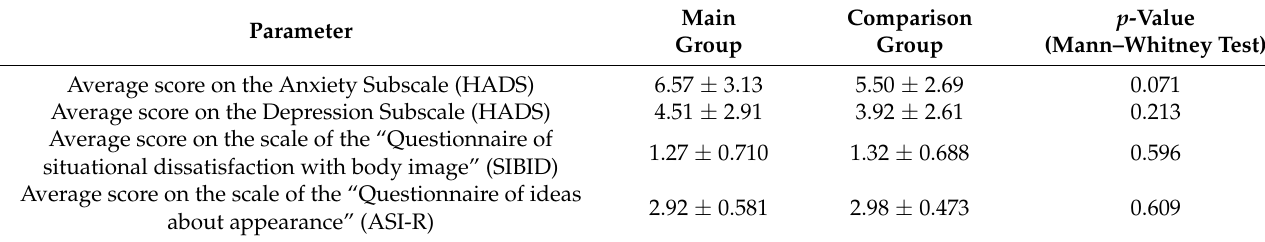
Table 8. The results of the assessment of the psycho-emotional status of patients (M ± SD).